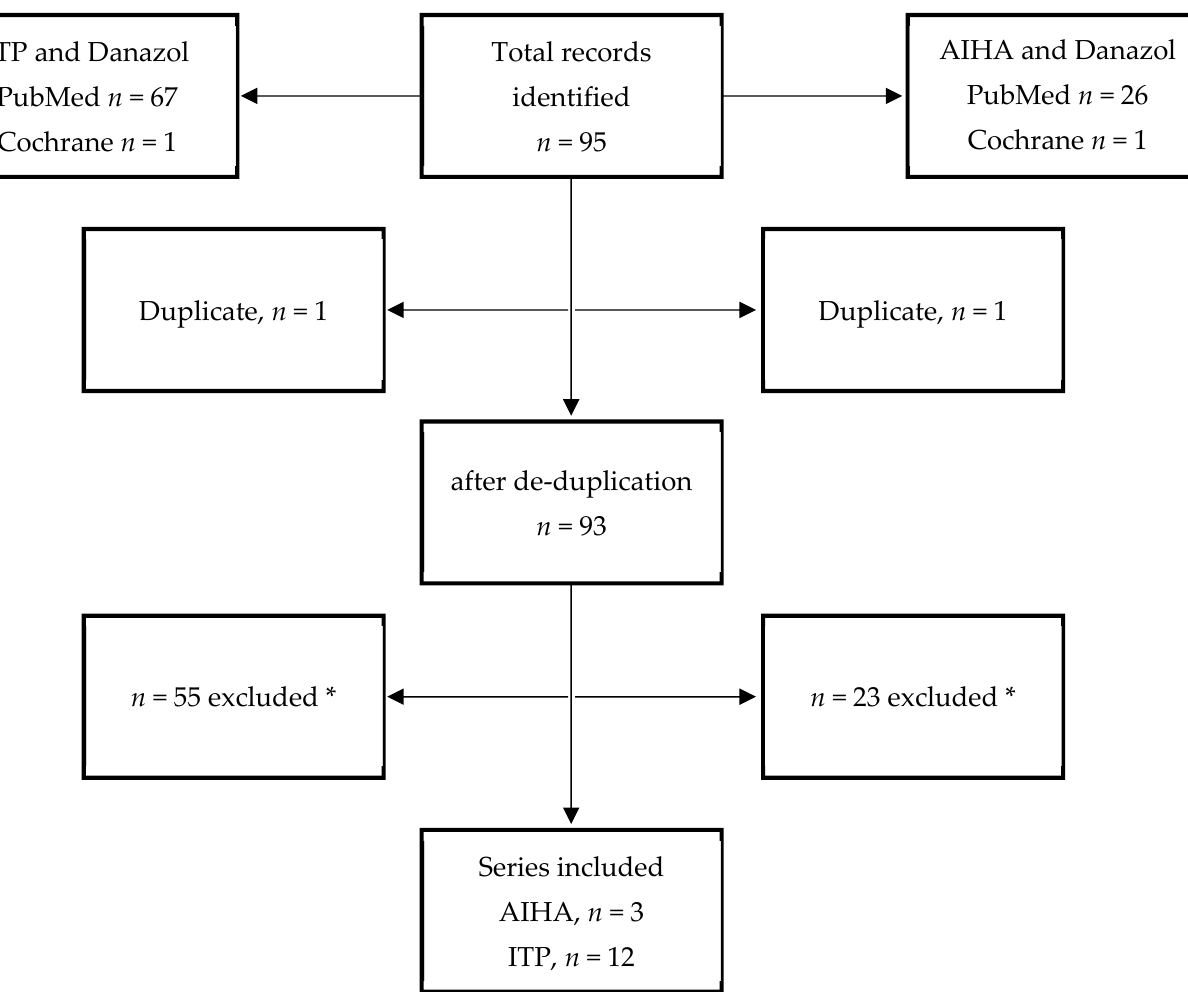
Figure 3. PRISMA flow diagram of study selection. ITP, immune thrombocytopenia; AIHA, autoimmune hemolytic anemia. * Excluded by title and reasons that do not pertain to study purposes. Table 2. Published studies on danazol for the treatment of immune thrombocytopenia and autoim- A total of 32 patients were included in three series of AIHA and danazol therapy. mune hemolytic anemia. Most of the patients ( n = 22, 68.8%) were female, with a mean age of 53.7 years. All the enrolled patients received GC treatment, and eight (25%) underwent splenectomy before the initiation of danazol. Of the 32 patients in these three series, 24 (75.0%) achieved a treatment response, including partial or complete, with an initial daily dose of danazol 400–800 mg, but no response rate was reported in those who received a low daily dose (<400 mg) of danazol. The duration of the disease available in the two series was 0.4 and 4.1 years each. AEs were reported in 7 of the 29 patients (24.1%) of the two series, including 3 patients (10.3%) with mild impairment of liver function without clinical symptoms, 1 (3.4%) with cramps and myalgia, 1 (3.4%) with facial hair growth, 1 (3.4%) with nervousness, and 1 (3.4%) with hair loss, but no patients withdrew from the